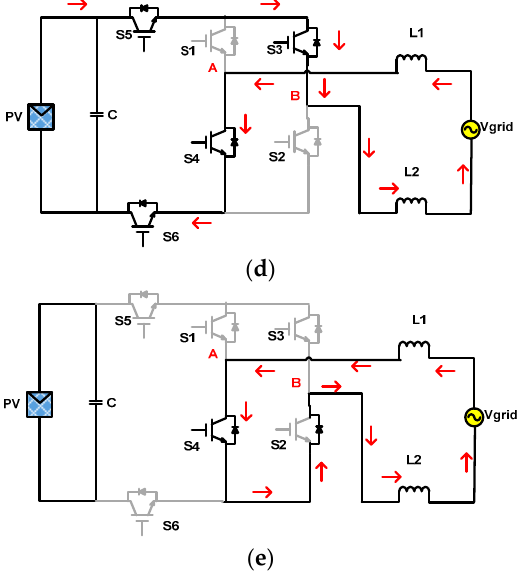
Figure 9 . H6 III inverter and its operating modes. ( a ) H6 III inverter circuit, ( b ) current conduction during the positive half cycle of the grid voltage, ( c ) freewheeling mode during the positive half cycle of the grid voltage, ( d ) current conduction during the negative half cycle of the grid voltage and ( e ) freewheeling mode during the negative half cycle of the grid voltage.